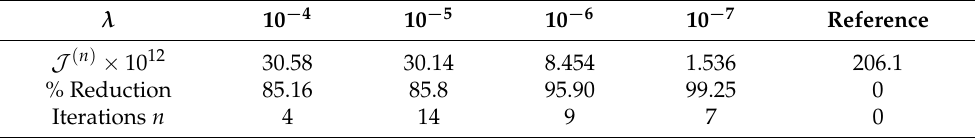
Figure 10. Velocity matching case with Neumann boundary control: optimal solution for λ = 10 − 6 . Contours of the temperature field T ( a ); contours and streamlines of the velocity field u ( b ); contours of the x -component of the velocity field u ( c ). The velocity magnitude is indicated by the region where the objective is set. Table 5. Velocity matching case with Neumann boundary control: objective functional, percentage of reduction, and number of iterations of the optimization algorithm for the reference case and different λ